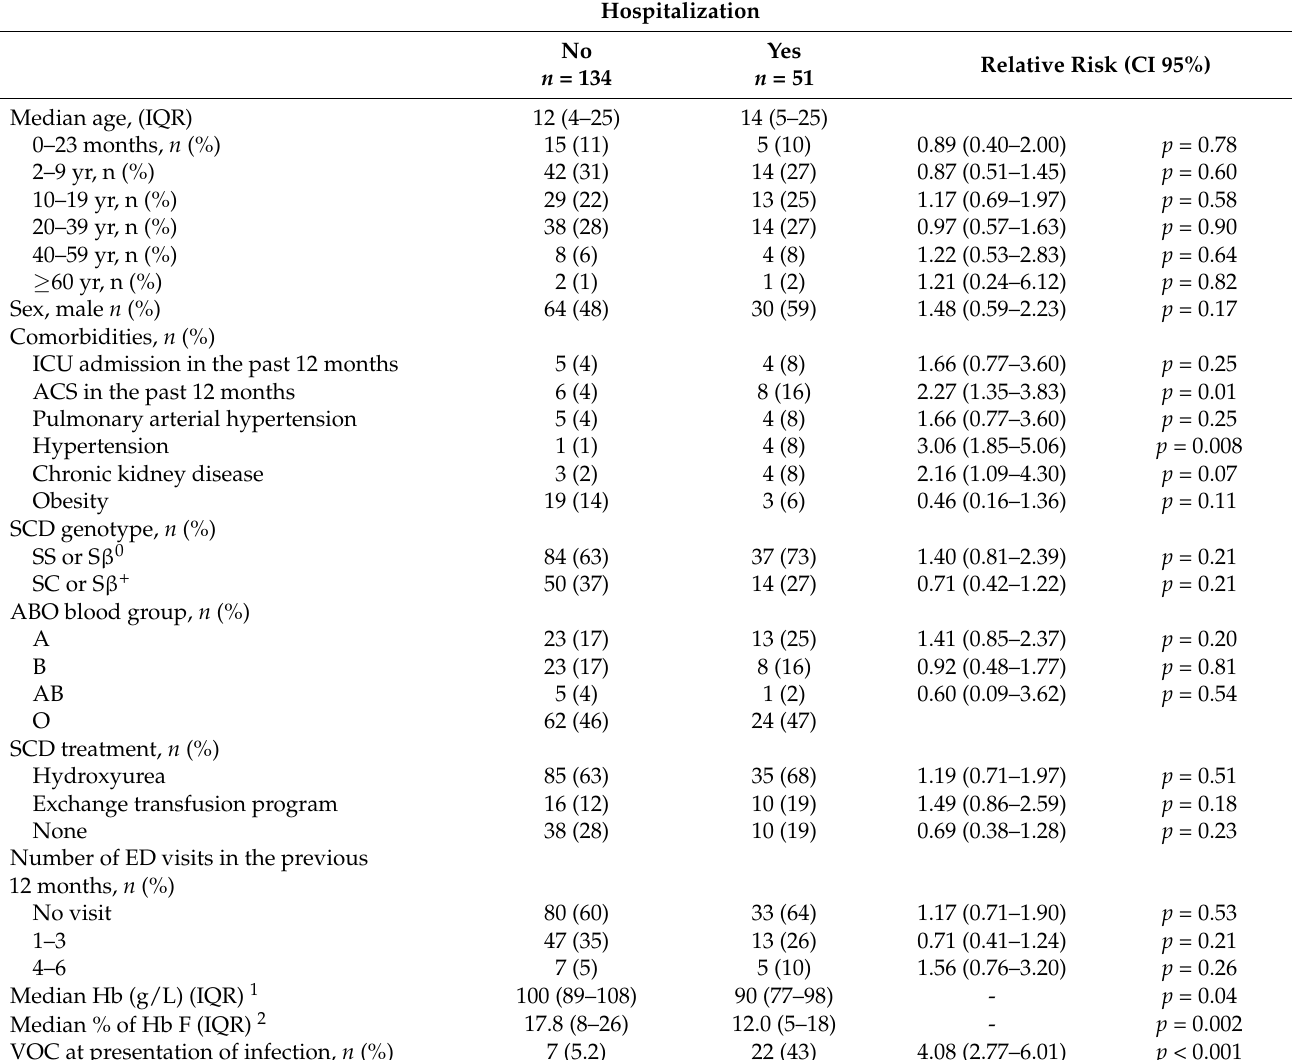
Table 4 identifies risk factors for hospitalization in the SCD population. Among the preexisting health conditions, hypertension and previous ACS in the prior year were as- sociated with a higher risk of hospitalization. Pain crisis as a presentation of infection is associated with an increased risk of hospitalization. Hospitalized patients had lower median fetal hemoglobin (Hb F), but no difference in Hb F was observed among hospital- ized patients with or without ACS (8.6 vs. 14.4%, p = 0.22, not shown in table). Age, sex, genotype, ABO blood group, baseline SCD treatment, and number of visits to the ED in the prior year had no impact on the risk of hospitalization. Regarding genotypes, SC was present in 27% and 28% (0.98 [0.57–1.63], p = 0.90) and SS in 69% and 62% (1.27 [0.76–2.11], p = 0.34) of hospitalized and non-hospitalized patients respectively and was not associated with an increased risk of severe infection. Table 4. Univariate analysis of potential predictors of hospitalization for SCD patients with SARS- CoV-2 infection. Relative risk ratios and 95% confidence intervals are presented. Hospitalization No Yes n = 134 n =